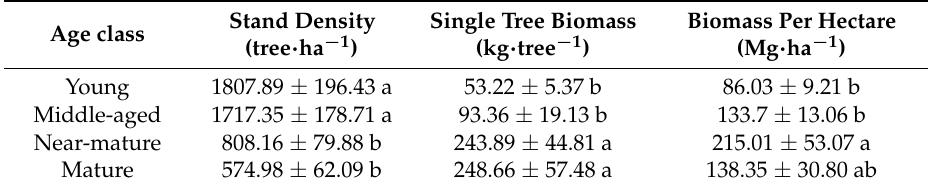
Table 3. Biomass of tree layer in Quercus variabilis stands.